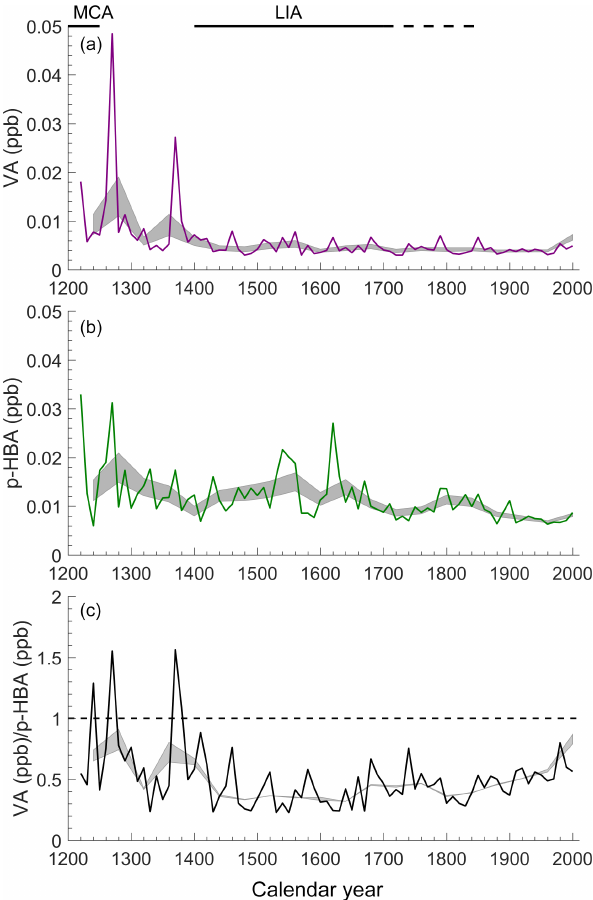
Figure 3. Lomonosovfonna ice core records of vanillic acid (a) and p -hydroxybenzoic acid (b) and the ratio of vanillic acid/ p - hydroxybenzoic acid (c) . For all plots: solid lines are 10-year bin averages, and gray shaded areas are 40-year bin averages of ± 1 standard error. The dashed line on the bottom plot indicates a ratio of 1. The black horizontal lines are the Medieval Climate Anomaly (MCA) and the Little Ice Age (LIA) (Mann et al., 2009). The dashed horizontal line at the top is the extended LIA in the Svalbard region (Divine et al., 2011).